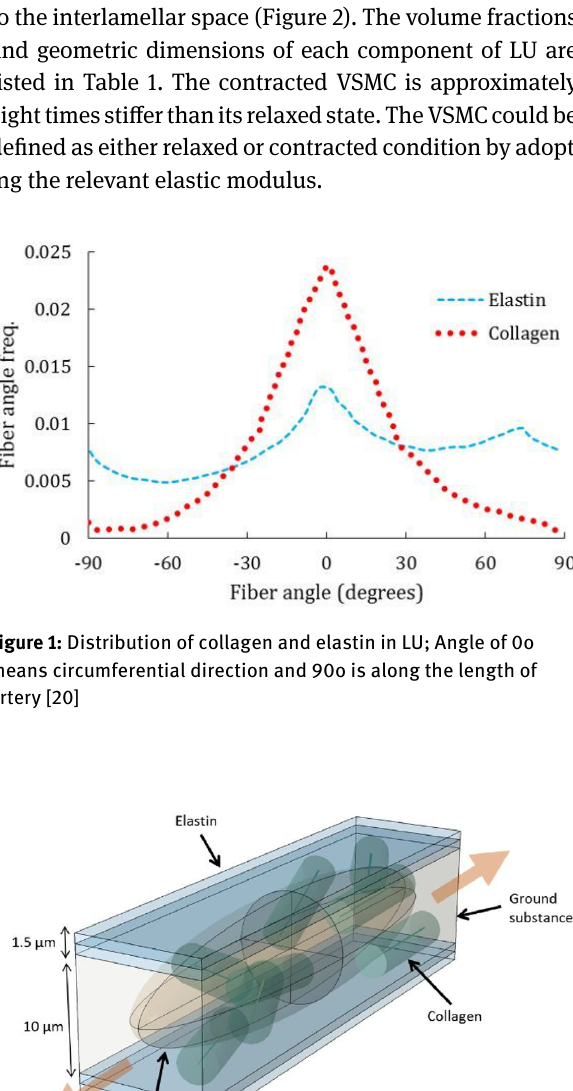
For collagen fibers, a bilinear constitutive